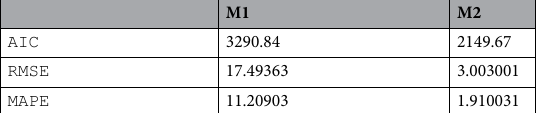
Table 1. Comparison of the two different ARIMA models for deceased donors: Model M1 with seasonality (ARIMA(0,1,2)(1,0,0) with drift) and Model M2 with seasonally adjusted data constructed by removing the seasonal component (ARIMA(5,1,0) with drift).